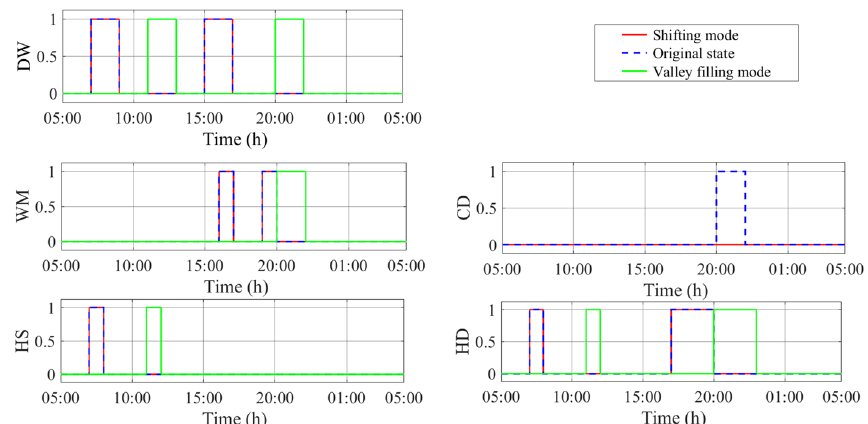
Fig. 9 Operating status of shiftable appliances case